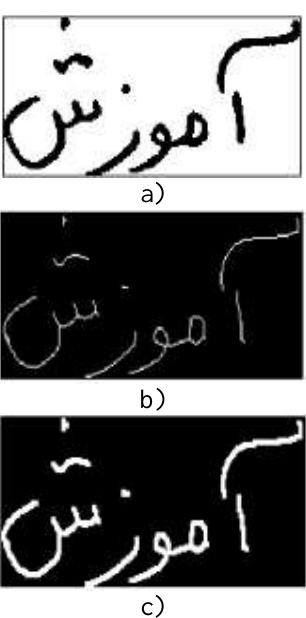
Figure2. An example of skeletonization and dilation. a) Original image. b) Word skeleton. c) Dilation on word skeleton.